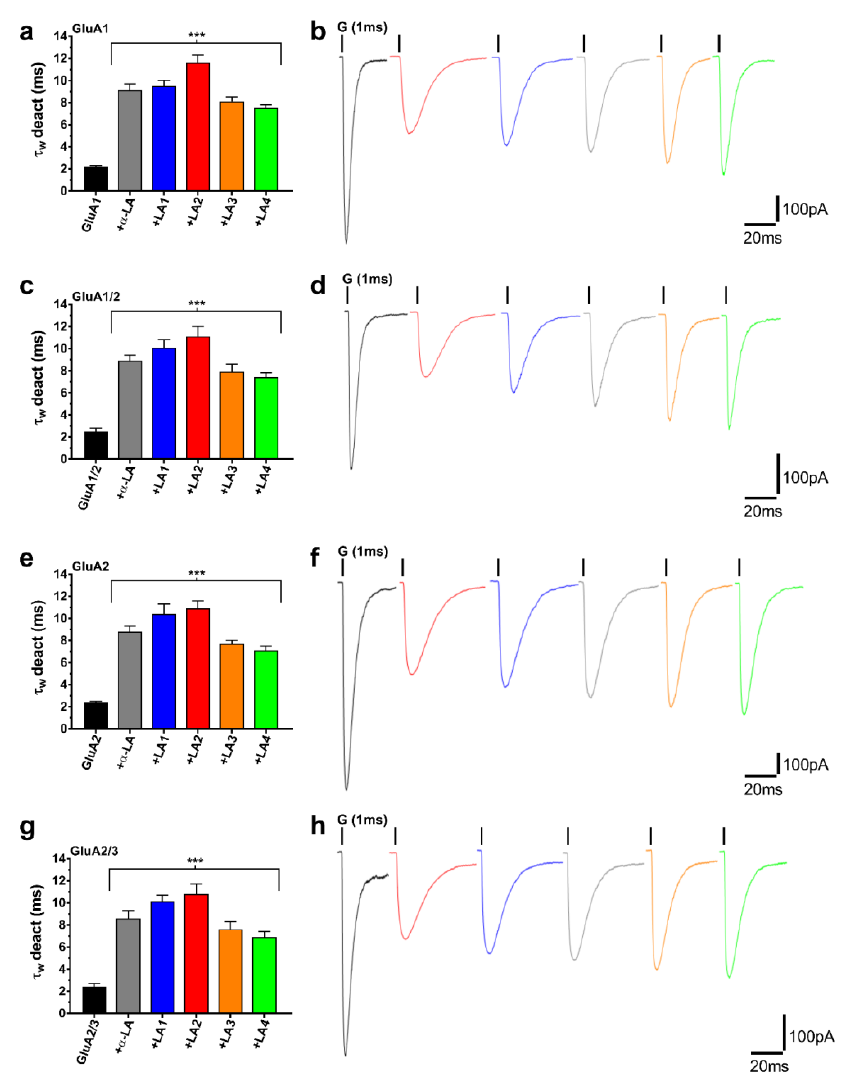
Figure 4. The effects of α -LA and its derivatives on AMPA receptor deactivation rate. As shown in the graphs, each subunit was influenced by the α -LA derivatives, with ( a ) representing the effect of α -LA derivatives on GluA1 deactivation rate, ( c ) representing the impacts of α -LA derivatives on GluA1/2, ( e ) representing the effects of α -LA derivatives on GluA2, and ( g ) demonstrating the effect of α -LA derivatives on the deactivation rate of GluA2/3. α -LA derivatives significantly affected AMPA receptor subunits, as seen by the traces in ( b , d , f , h ). The whole-cell current was measured at − 60 mV, pH 7.4, and 22 °C. A one way analysis of variance (ANOVA) was performed for comparison: *** p < 0.001; ns, not significant. Ten cells were investigated for each LA compound. As stated in the supplementary material tables, the cells were washed for 20 s between α -LA compounds, and a 10 mM glutamate was supplied alone after each α -LA compound (12 µ M) to ensure cell health. All values are shown as mean SEM.